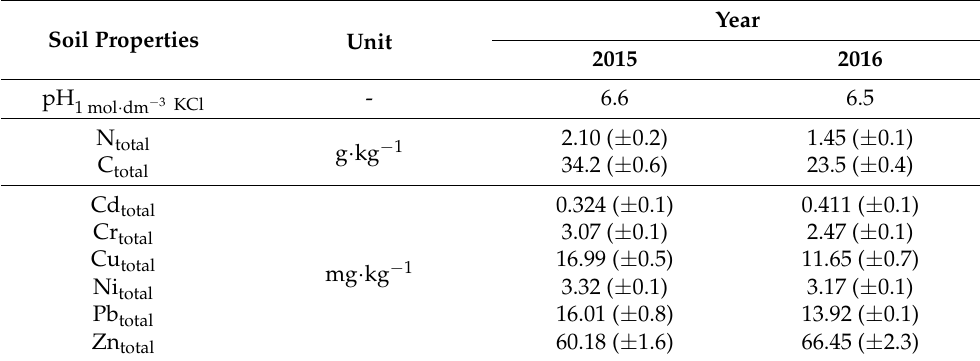
Table 1. Selected soil properties, value of parameter and ( ± SD), N =